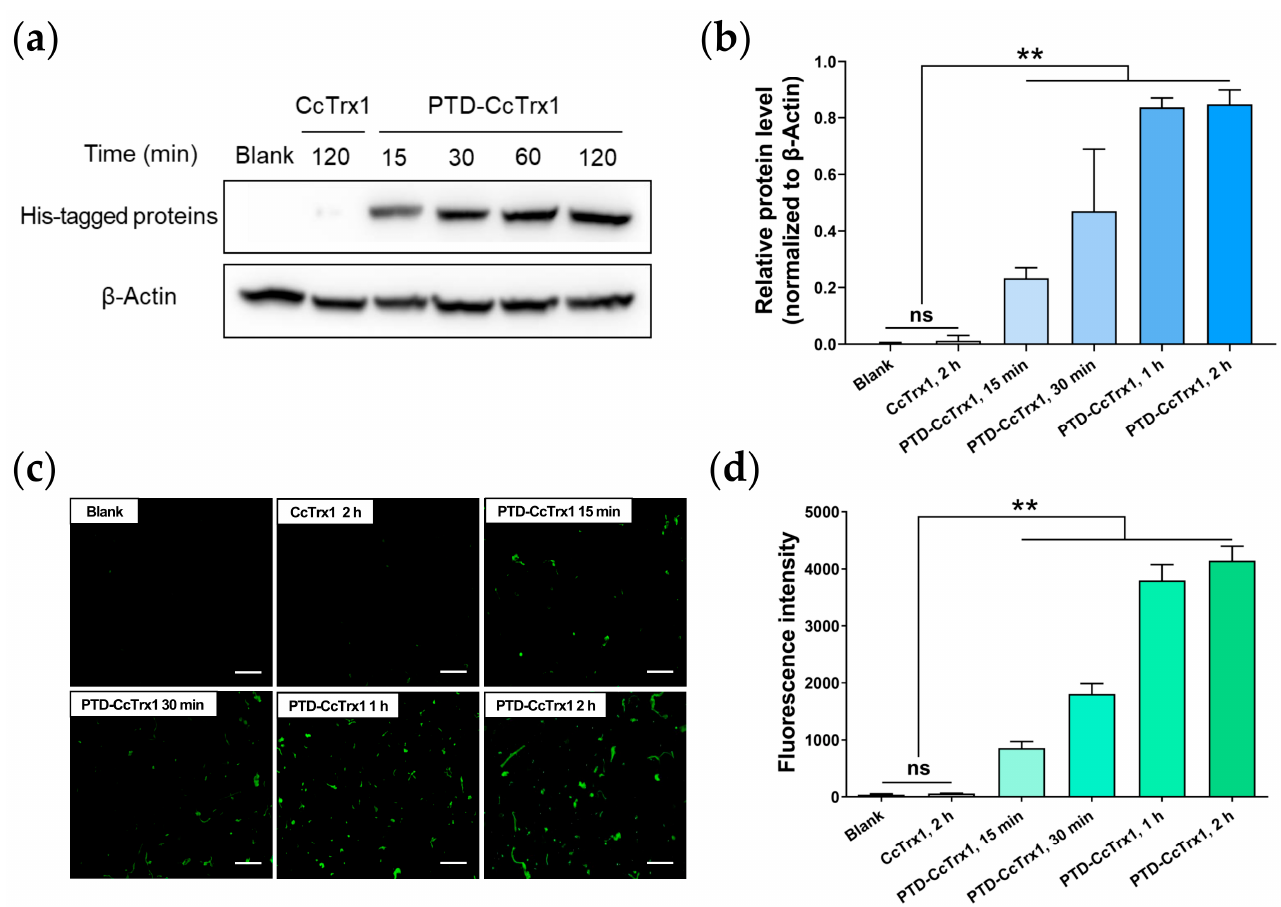
Figure 2. Transduction of PTD-CcTrx1 into HaCaT cells. First, HaCaT cells were incubated with 4 µ M PTD-CcTrx1 for 15 min, 30 min, 1 h, 2 h, respectively. PBS and 4 µ M CcTrx1 were used as a blank and negative control. Then, cells were rinsed with ice-cold PBS thoroughly, and the intracellular His-tagged proteins were detected by the anti-His-tag antibody via the Western blot assay and immunofluorescence assay. ( a ) Western blot analysis of intracellular His-tagged proteins using anti-His-tag antibody at different times. ( b ) Intracellular His-tagged proteins were quantified using densitometric analysis with β -Actin as the internal control. ( c ) Intracellular amount of His-tagged proteins at different times after incubation detected by immunofluorescence assay. Bar = 100 µ m. ( d ) The fluorescence data were quantified by ImageJ software. Quantification data were obtained from three independent experiments, and the data are presented as means ± SD ( n = 3) (ns, no significance, ** p < 0.01 vs. blank group).